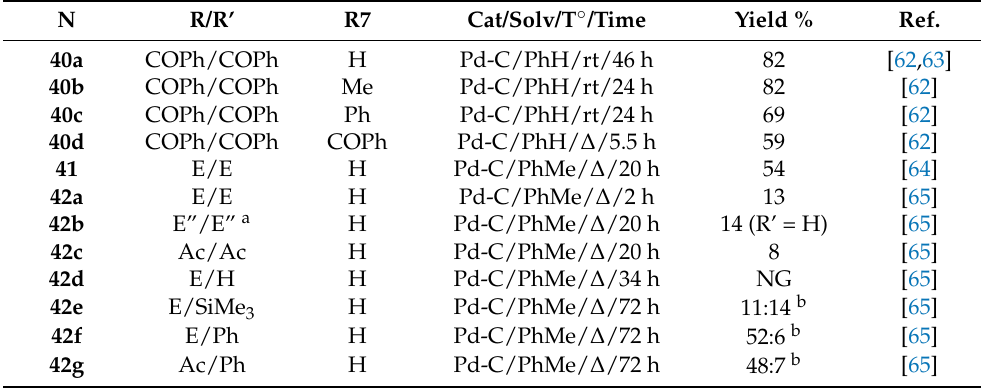
Table 9. Substituents, conditions and yields in cycloaddition of acetylene to 3-CN-substituted benzoindolizines giving benzocyclazines (Scheme 18).